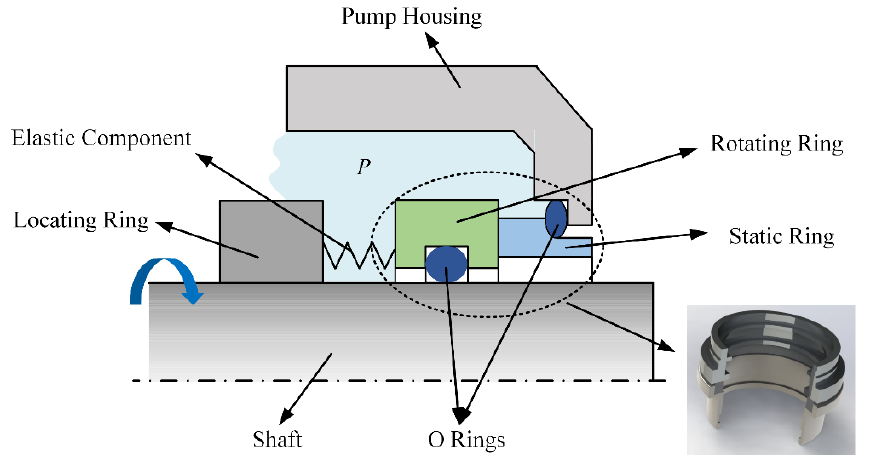
Table 5. Operating conditions of the degradation test. Figure 10. Schematic of mechanical seals. Figure 10. Schematic of mechanical seals.